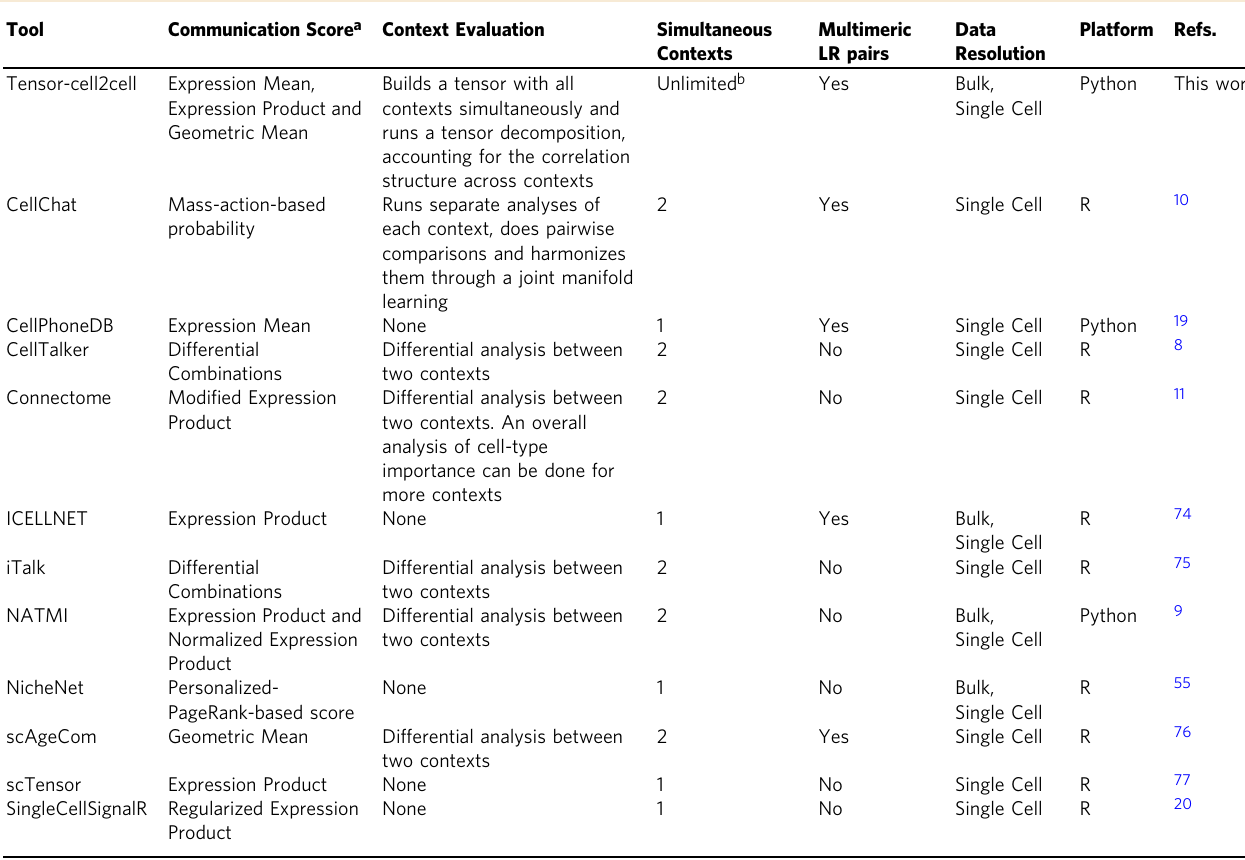
Table 1 Methodological strategy and context-based analysis in available